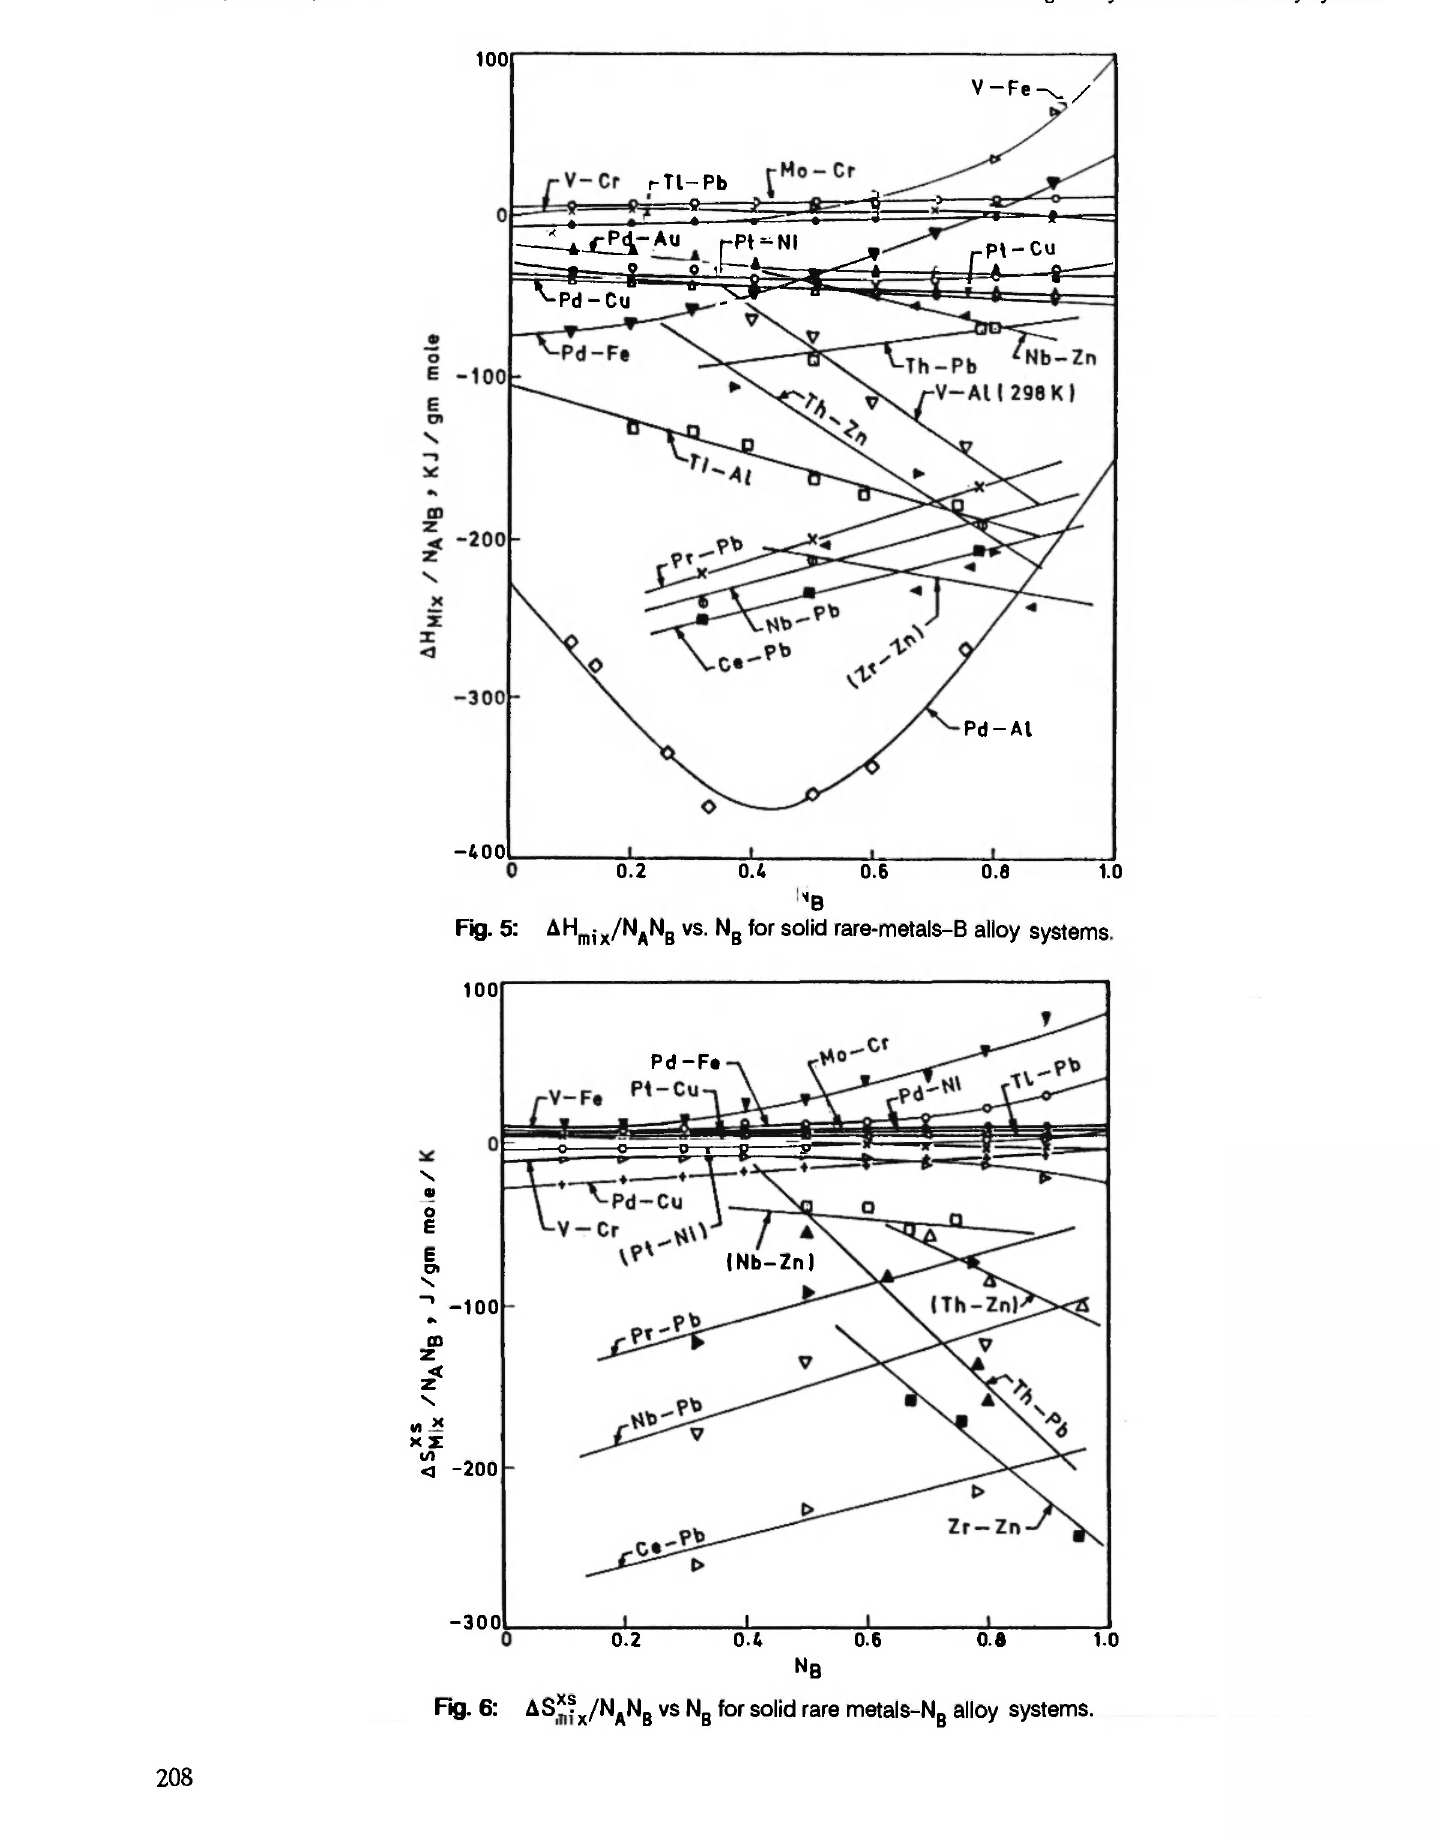
AS*? X /N A N B vs N ß for solid rare metals-N B alloy